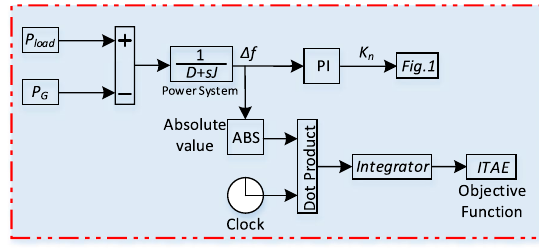
Fig. 2 The proposed control method of